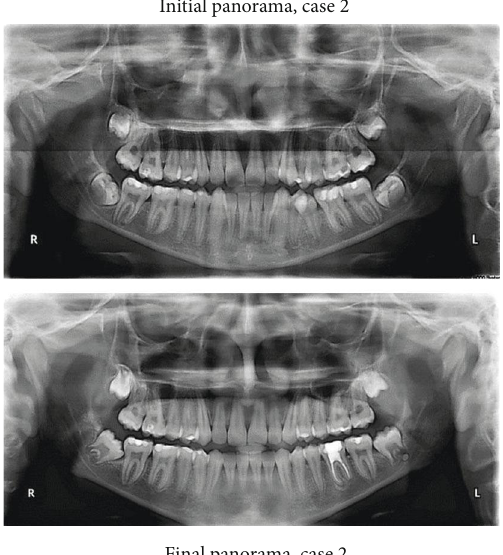
Figure 11: Initial and fi nal panoramic